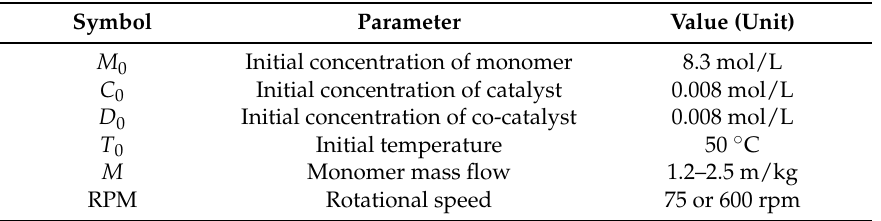
Table 1. Extrusion reaction